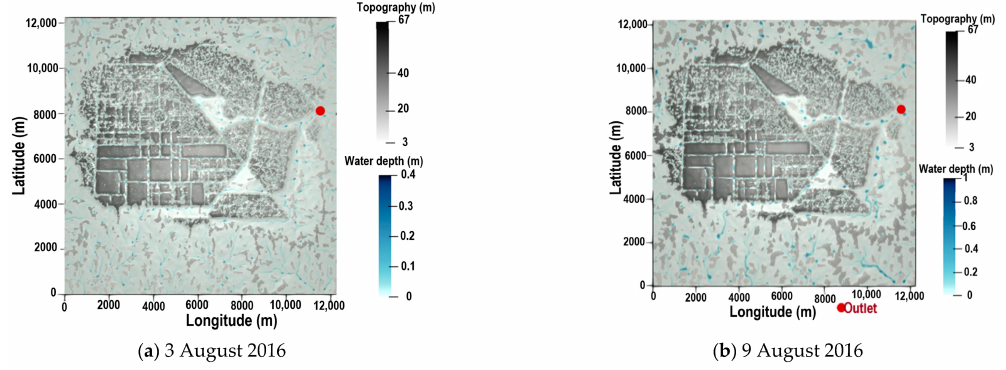
Figure 10. Flood extent for real